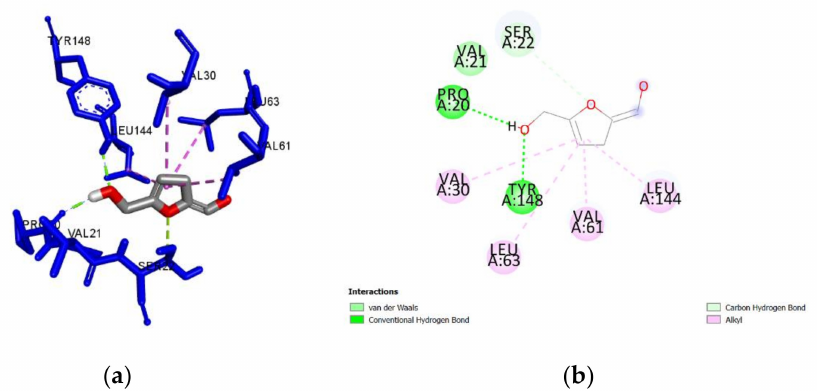
Figure 6. ( a ) Docked pose of 5-hydroxymethyl-2-furaldehyde in the Pa DsbA1 binding site showing molecular interactions—hydrogen and hydrophobic bonds shown as green and pink / purple dashed lines, respectively; ( b ) 2D plot of interactions between 5-hydroxymethyl-2-furaldehyde and key residues of Pa DsbA1 generated by BIOVIA Discovery Studio